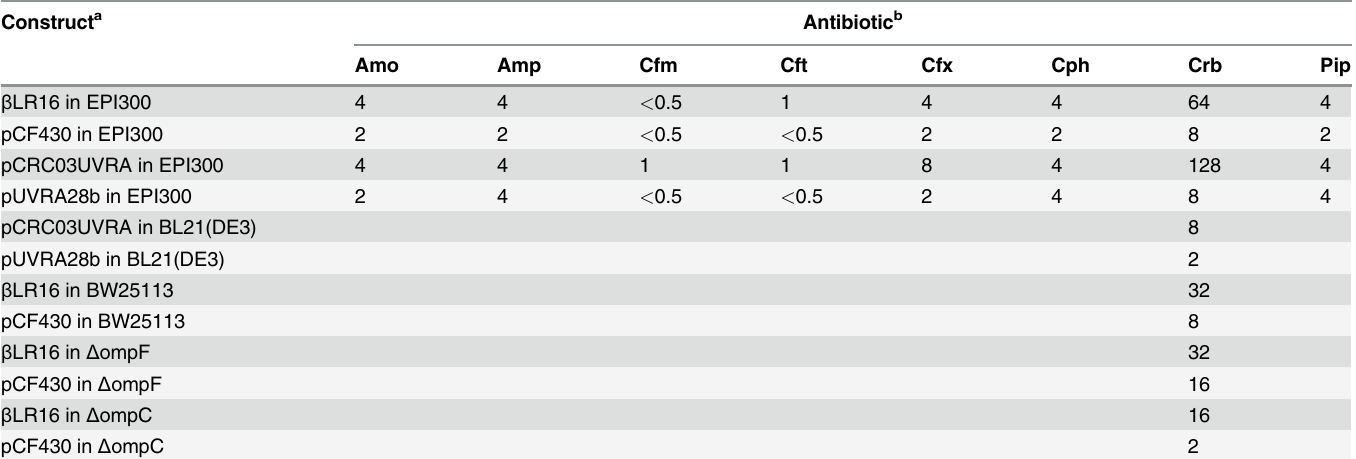
Table 3. Minimum inhibitory concentration (MIC; μ g ml -1 ) of β -lactams on recombinant E . coli cells harboring constructs from this work. Construct a